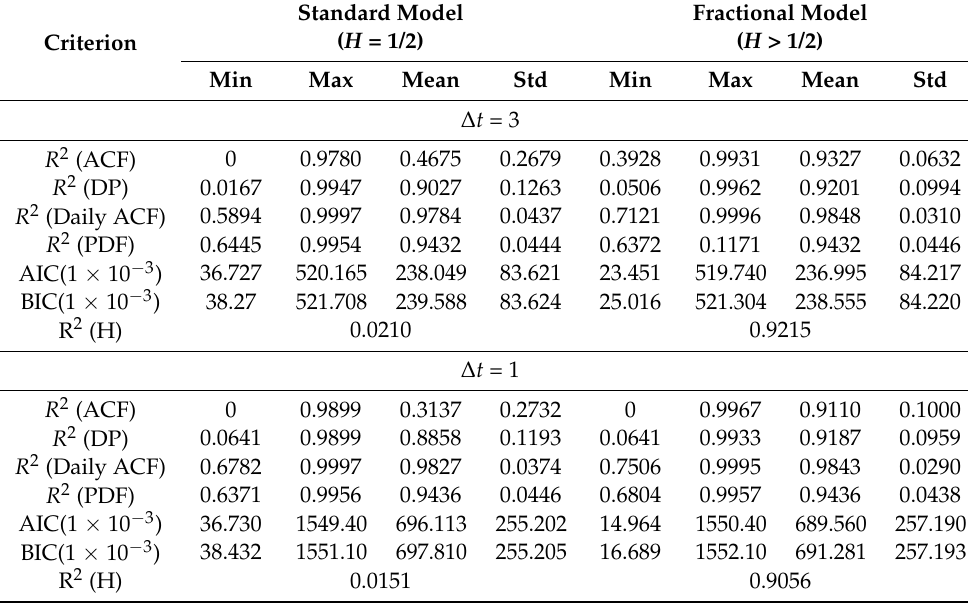
Table 3. Model comparison